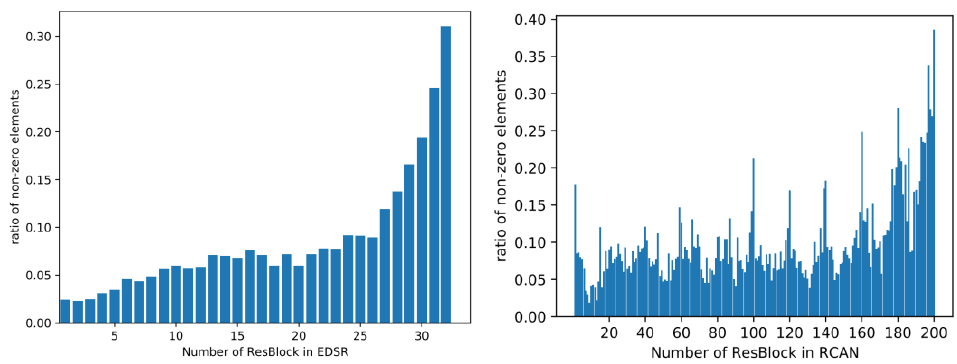
Figure 1. Ratio of the non-zero elements in the feature maps of EDSR and RCAN.